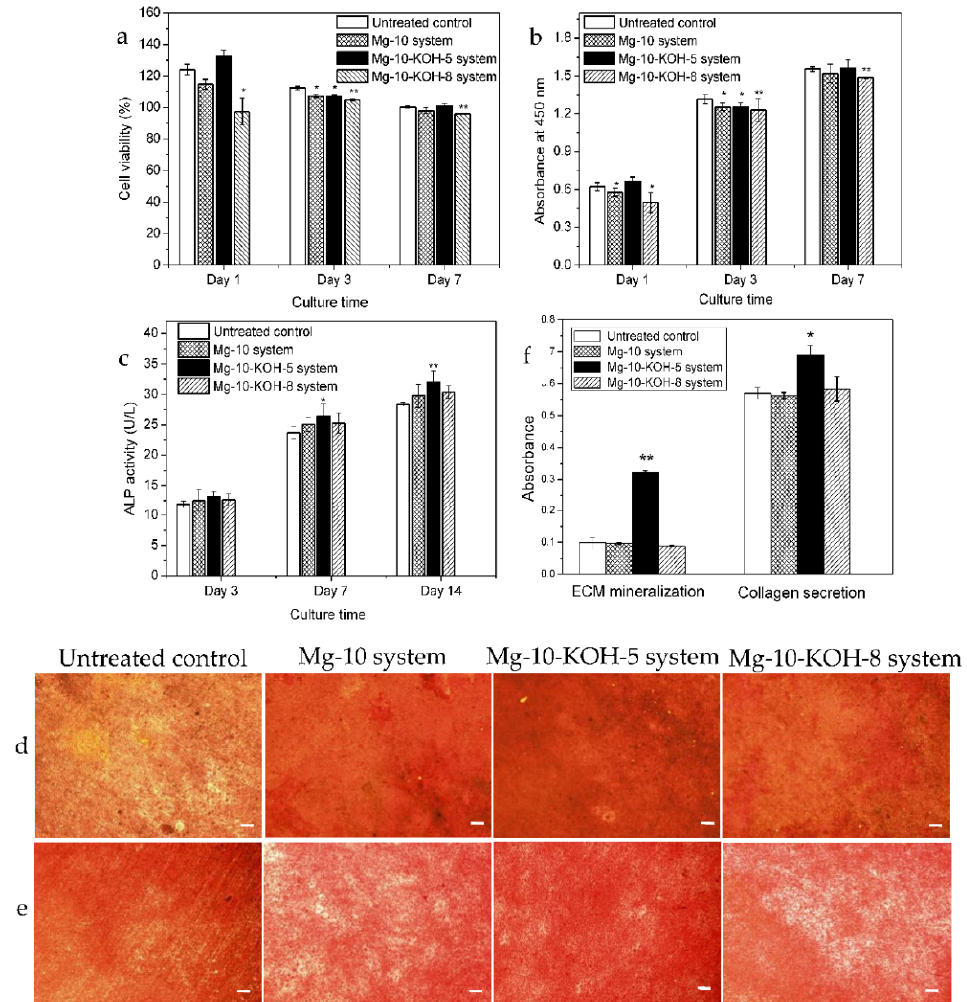
Figure 8. In vitro cytocompatibility evaluation of the MAO samples after culturing MC3T3-E1 pre- osteoblasts for a different period. ( a ) Cell viability, ( b ) cell proliferation, ( c ) ALP activities, ( d ) ECM mineralization, ( e ) collagen secretion and ( f ) the quantitative expression of ECM mineralization and collagen secretion * p < 0.05 and ** p < 0.01 versus the untreated control. Scale bar is 200 μ m.